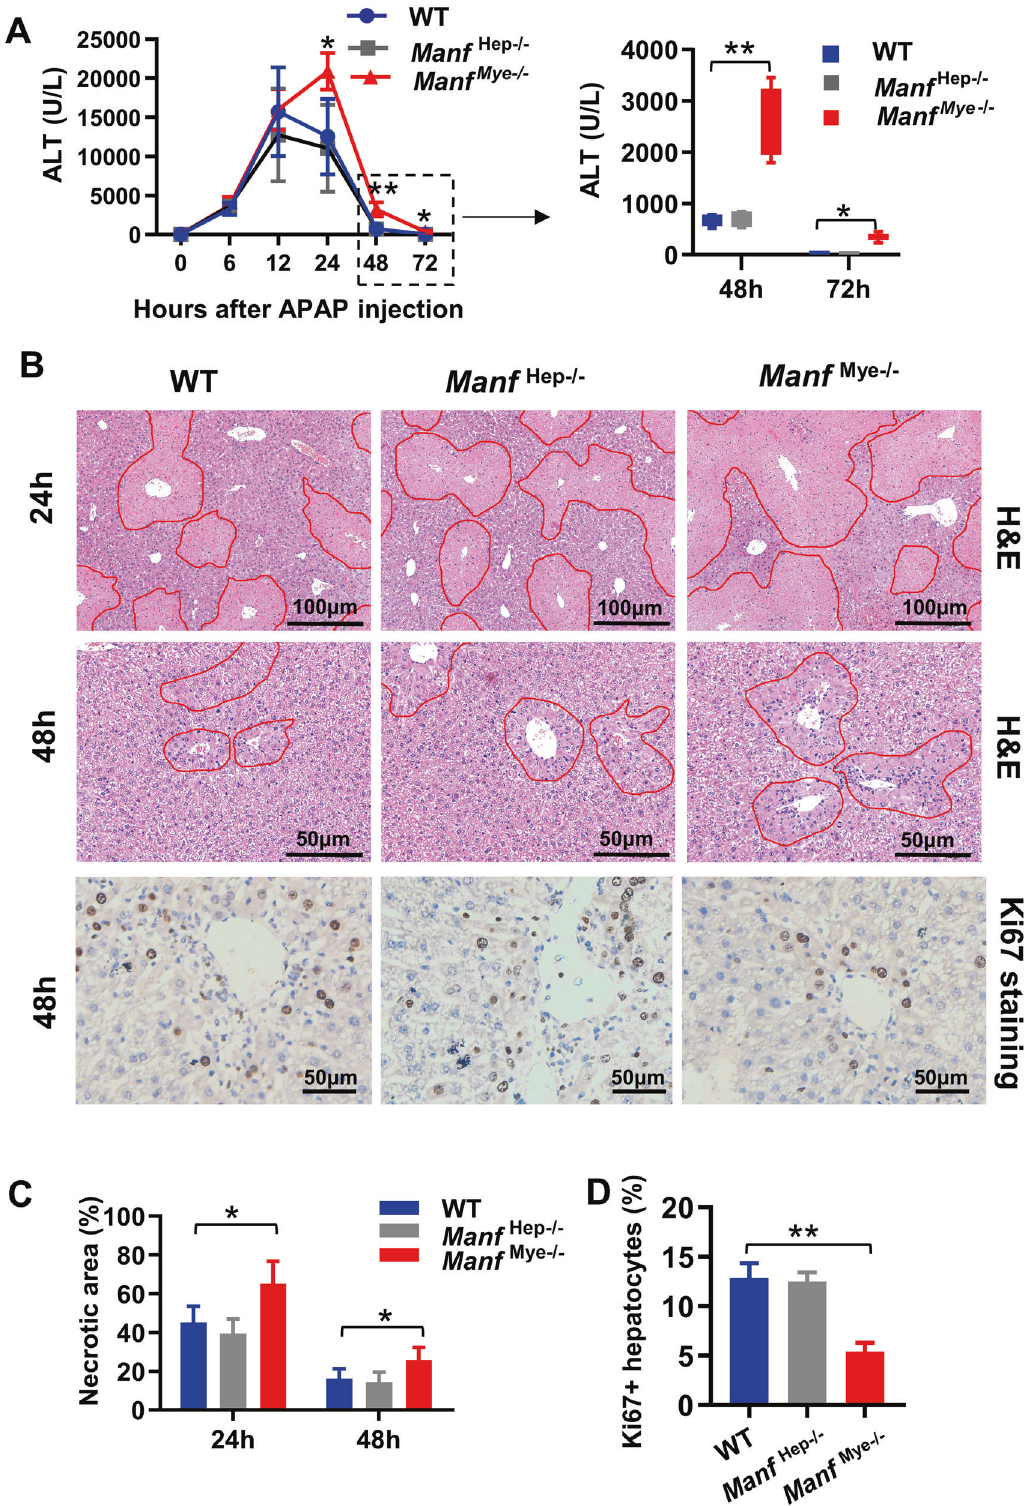
Fig. 2 Manf Mye-/- mice display delayed liver recovery after APAP treatment. WT mice, Manf Mye-/- mice, and Manf Hep-/- mice were intraperitoneally injected with APAP. A Serum ALT levels were measured after APAP treatment. B Representative H&E-staining and IHC staining for Ki67 in liver sections after APAP treatment. Necrotic areas were outlined using red lines. The percentages of necrosis area C and Ki67 D positive hepatocytes were quanti fi ed from 5 to 7 random view fi elds of each section (×200 magni fi cation) using ImageJ software. n = 5 – 7/ group, 3 independent experiments. Data are presented as mean ± SD. * P < 0.05, ** P < 0.01.